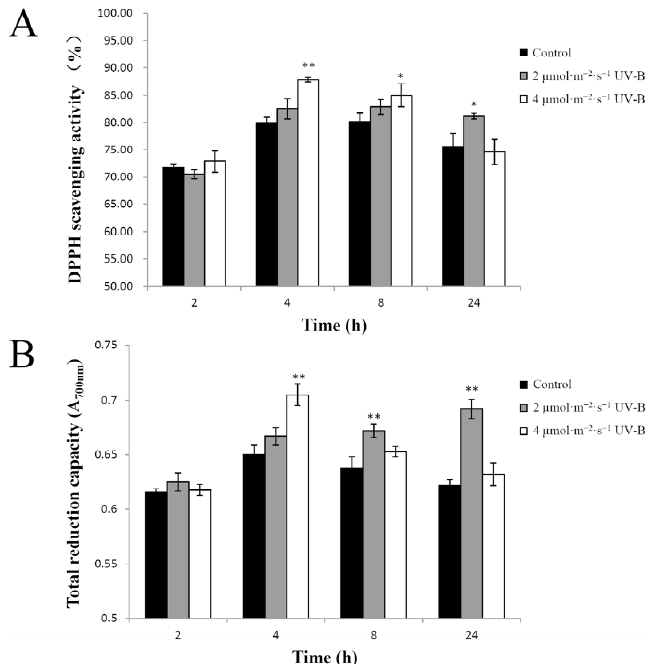
Figure 2. The effect of UV-B radiation on the total antioxidant capacity of pakchoi. ( A ) The 1,1–diphenyl-2-picrylhydrazyl (DPPH) scavenging activity of 25-day-old seedlings treated with either 2 µmol·m − 2 ·s − 1 or 4 µmol·m − 2 ·s − 1 of UV-B irradiation at 2 h, 4 h, 8 h, or 24 h. ( B ) The total reduction capacity of 25-day-old seedlings treated with either 2 µmol·m − 2 ·s − 1 or 4 µmol·m − 2 ·s − 1 of UV-B irradiation at 2 h, 4 h, 8 h, or 24 h. The plants not exposed to UV-B radiation served as controls. Three independent experiments were performed and data points represent the mean ± SE of three biological replicates. Asterisks indicate a significant difference (* p < 0.05; ** p < 0.01) to the corresponding control, using Student’s t -test.